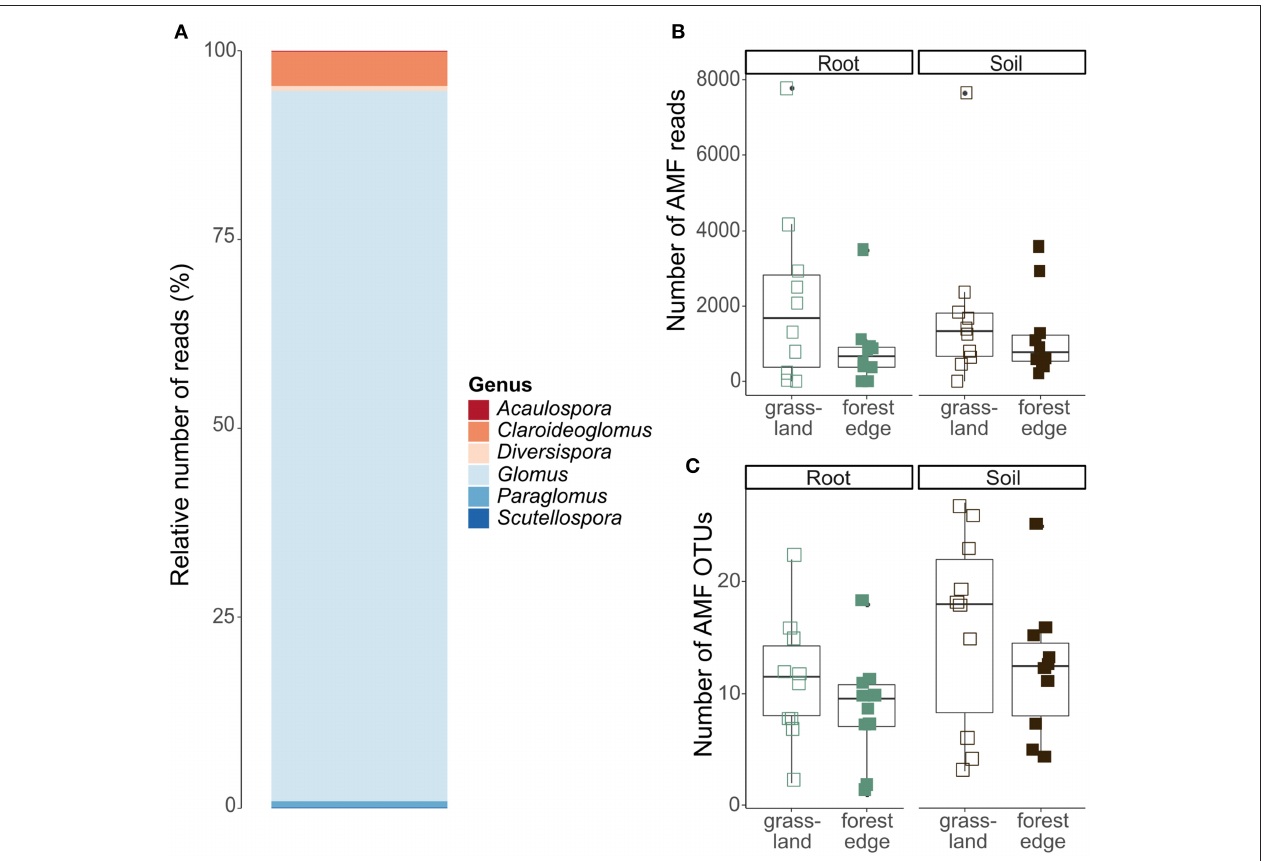
FIGURE 4 | Arbuscular mycorrhizal community composition and OTU diversity in the roots of Crataegus monogyna collected in grassland and forest edge vegetation as determined through metabarcoding with the AMV4.5NF and AMDGR primer pair. (A) Relative number of sequences of AMF genera. (B) The number of AMF sequences did not differ between the mixed AM + EcM vegetation of the forest edge and the AM-dominated grassland vegetation or between soil and root samples. (C) AMF OTU richness was lower in samples from the forest edge compared to samples from grassland and in root samples compared to soil